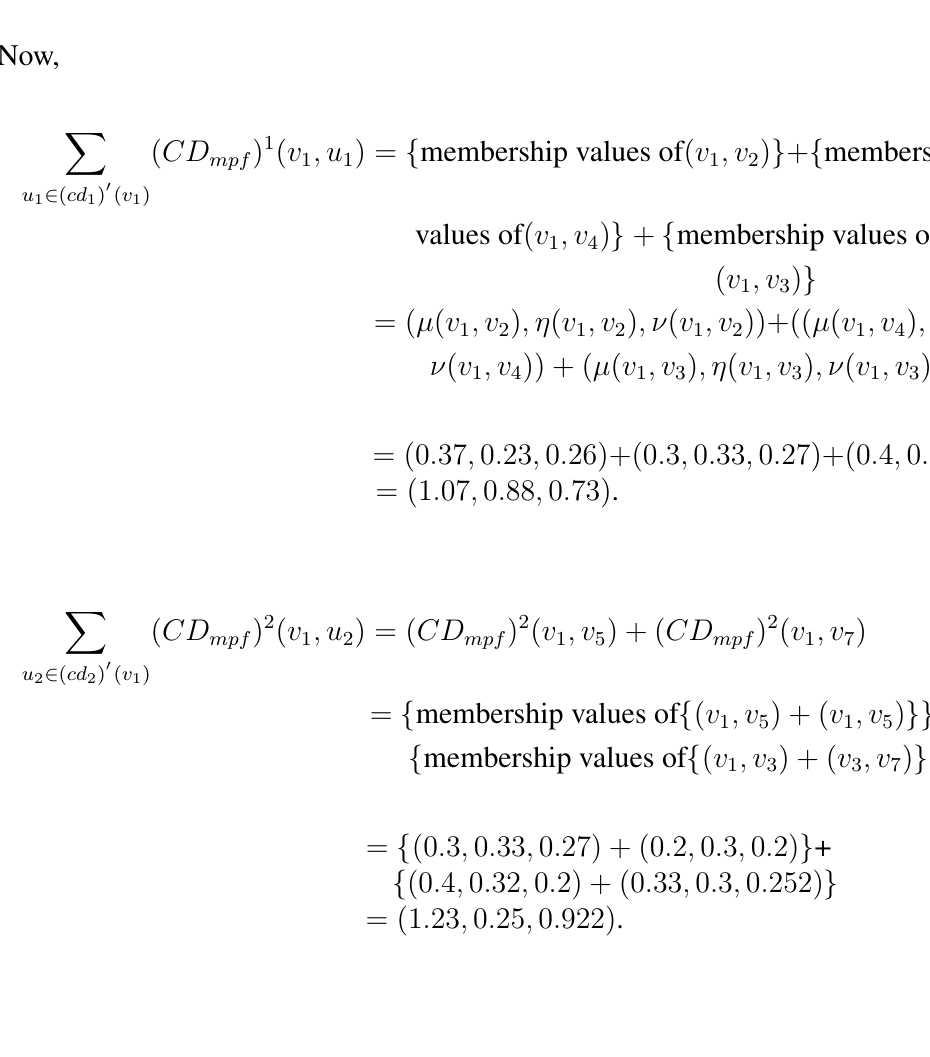
Figure 7: Mixed picture fuzzy